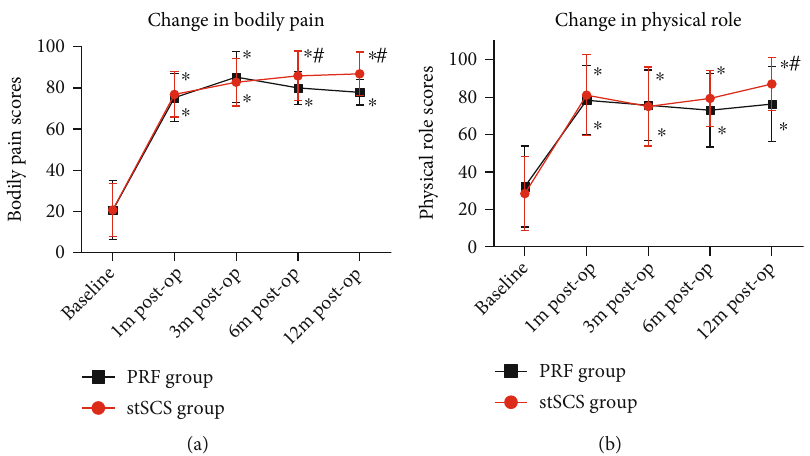
Figure 4: Pre- and postoperative SF-36 scores (bodily pain scores and physical role scores). ∗ P < 0 : 001 indicates postoperation vs. baseline. # P < 0 : 05 indicates PRF group vs. stSCS group.